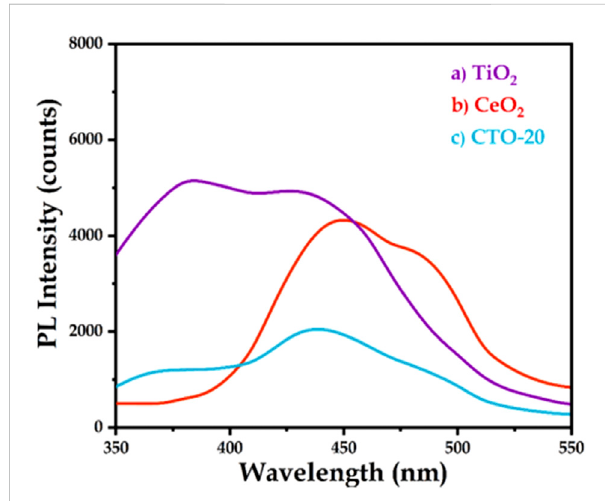
FIGURE 8 PL spectra of TiO 2 , CTO-20, and CeO 2 nanomaterials. Reproduced with permission from reference (Lu et al.,